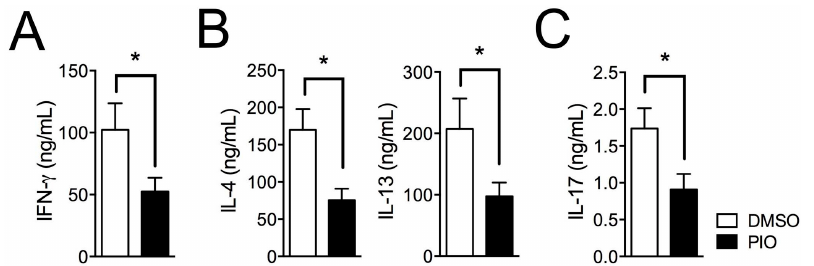
Figure 2. Cytokine production in female mouse Th1, Th2, and Th17 cells is reduced by pioglitazone treatment. The accumulated production of IFN- γ in Th1 cells ( A ); IL-4 and IL-13 in Th2 cells ( B ); and IL-17A in Th17 cells ( C ) in culture supernatants from female T cells treated with DMSO or pioglitazone was measured by ELISA assay. Values represent mean ± SEM ( n = 5~6). * p < 0.05. Int. J. Mol. Sci. 2016 , 17 , 1347